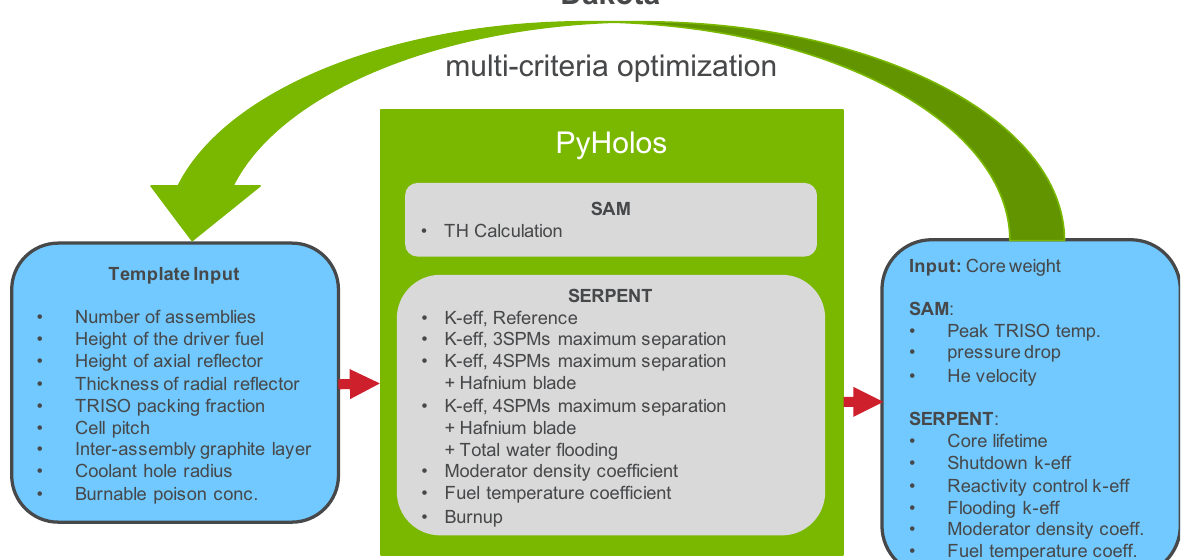
Figure 3. Overview of the PyHolos software framework for Holos-Quad optimization.